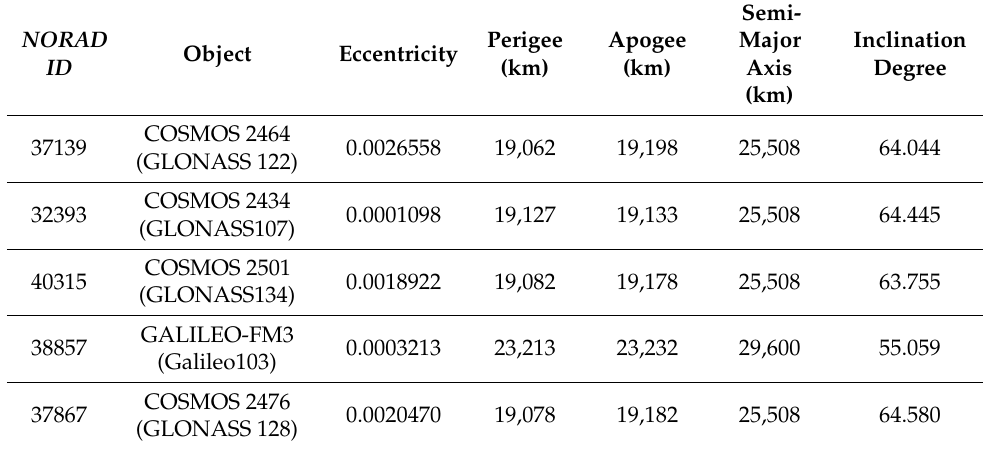
Table 4. The description of space object targets in MEO.